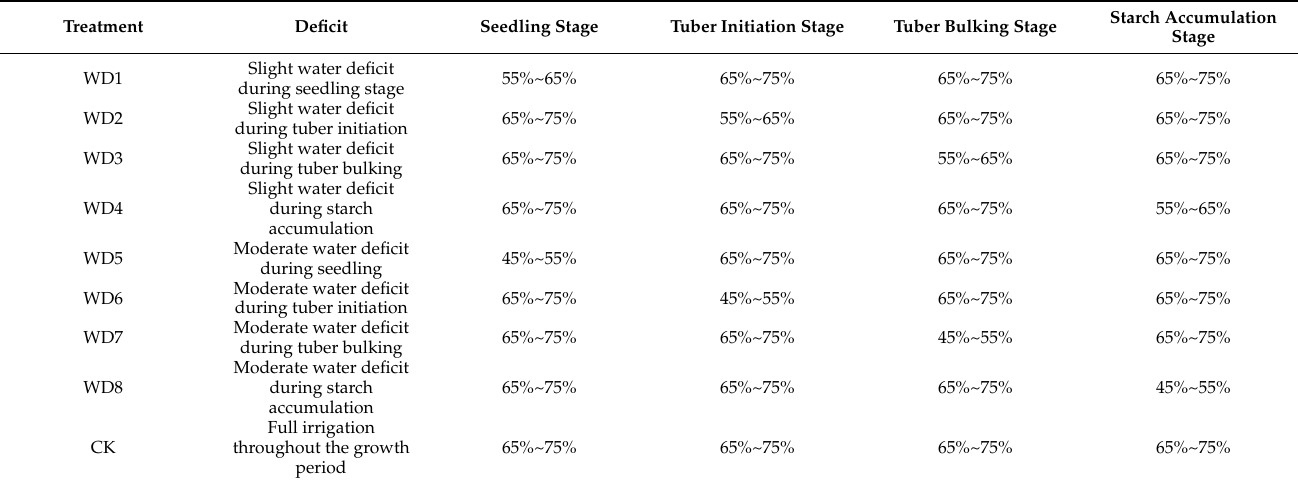
Table 1. Experimental